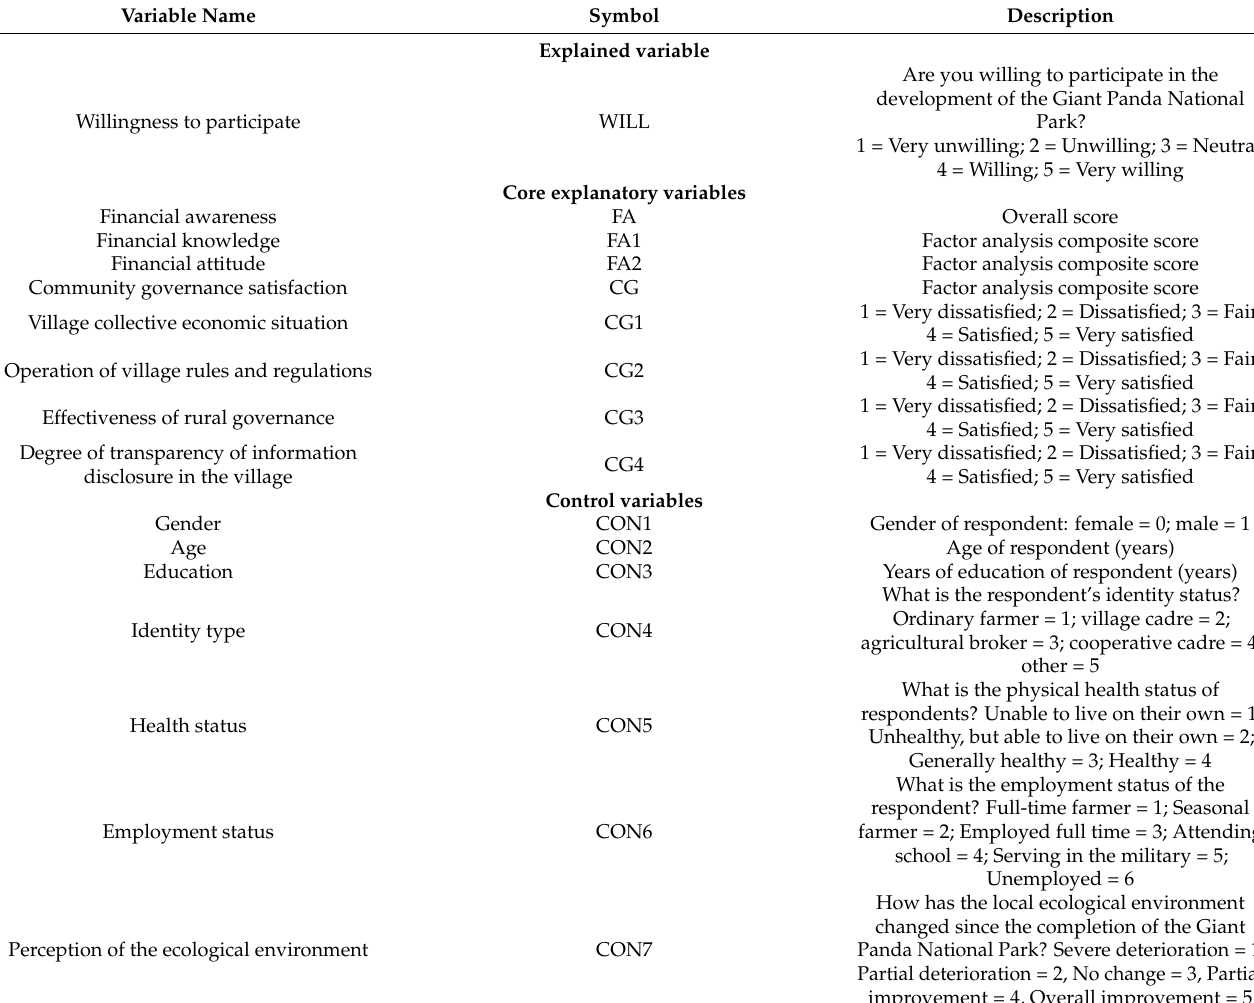
Table 1. Variable descriptions and descriptive